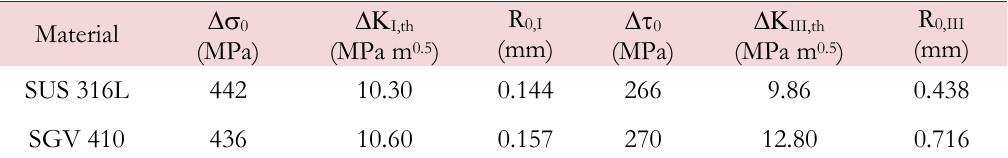
Table 1: Mechanical properties